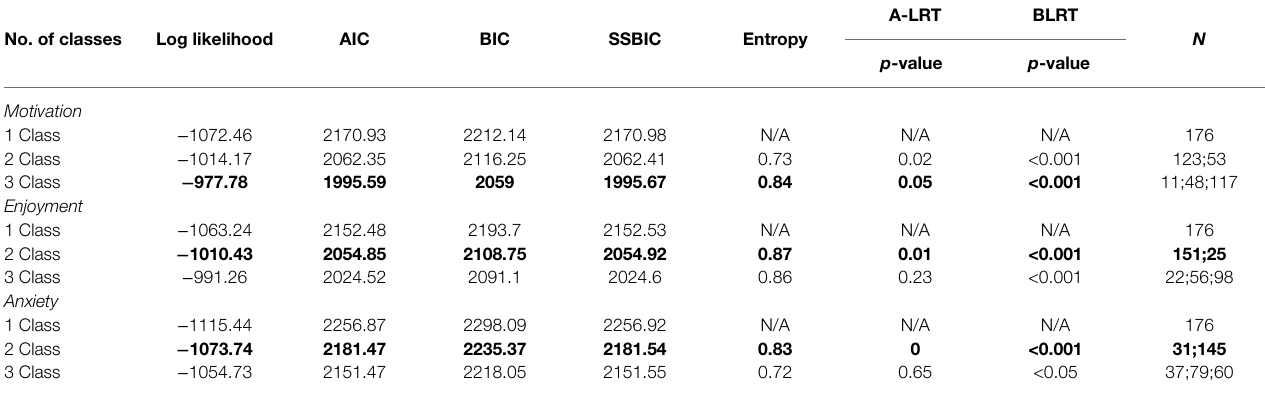
TABLE 2 | Fit information for the GMM.